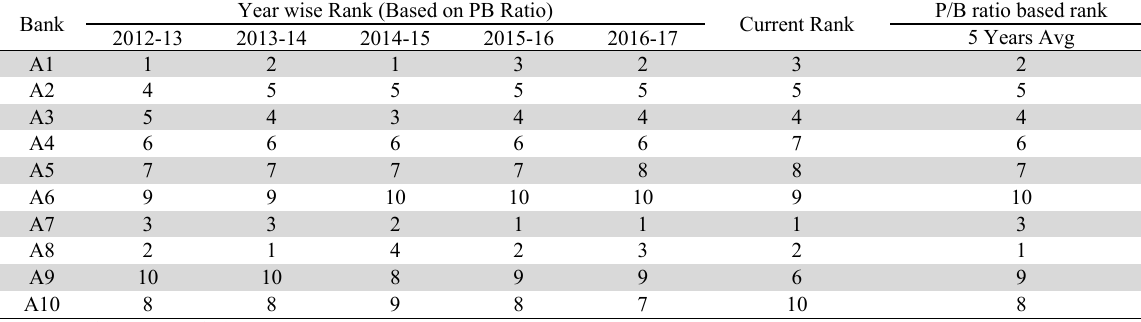
Year wise ranking of banks based on PB